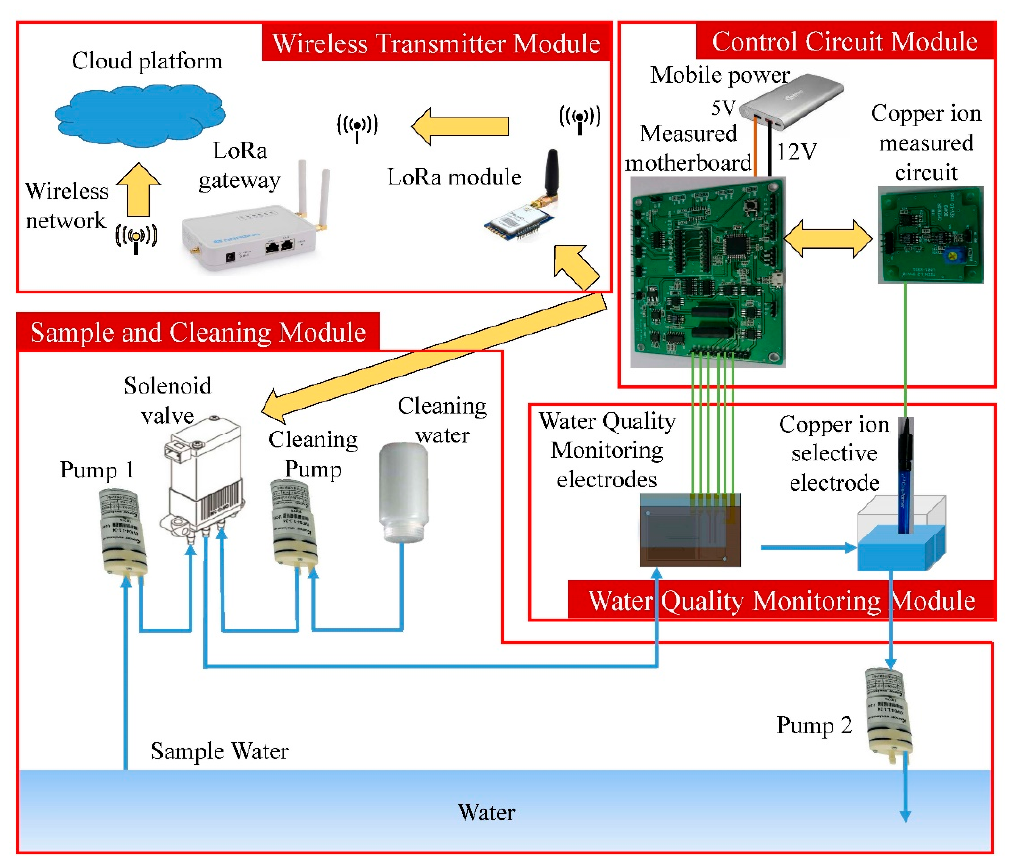
Figure 1. A block diagram of the miniaturized water quality monitoring system.